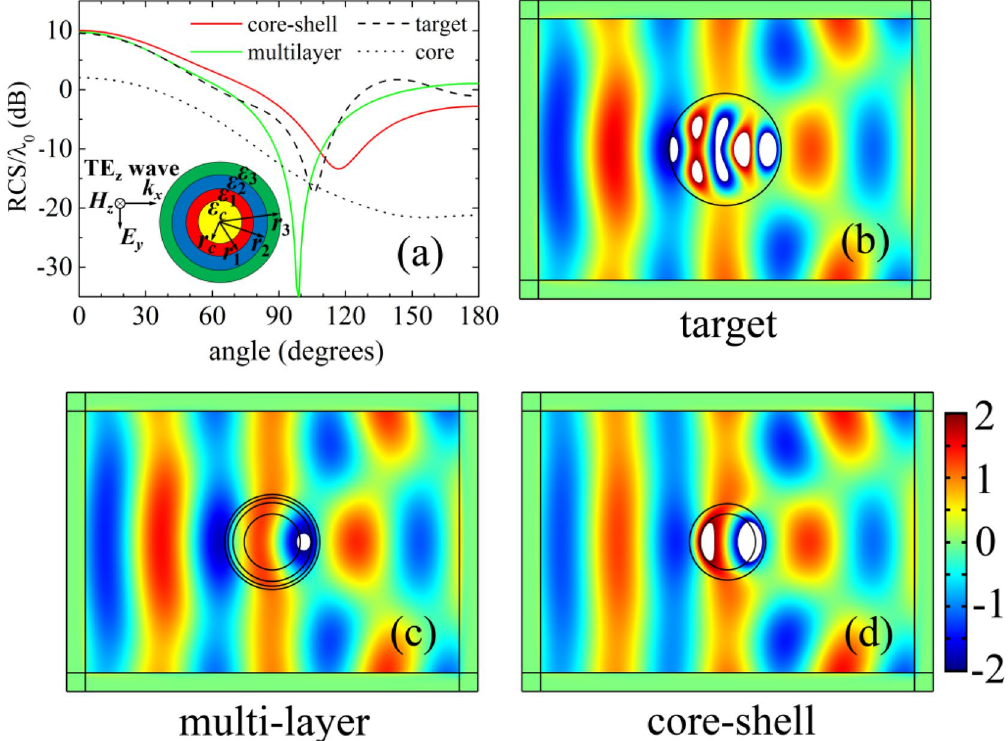
Figure 3. (a) The scattering widths normalized by wavelength for the target cylinder with radius r t = λ 0 / 2 (dashed black line), the core cylinder with radius r c = λ 0 / 4 (dotted black line), the optimized multi-layered design (solid green line), and the optimized core–shell design (solid red line). The inset shows that a core cylinder coated by three layers of homogeneous and isotropic materials. The magnetic field distributions of the target (b)